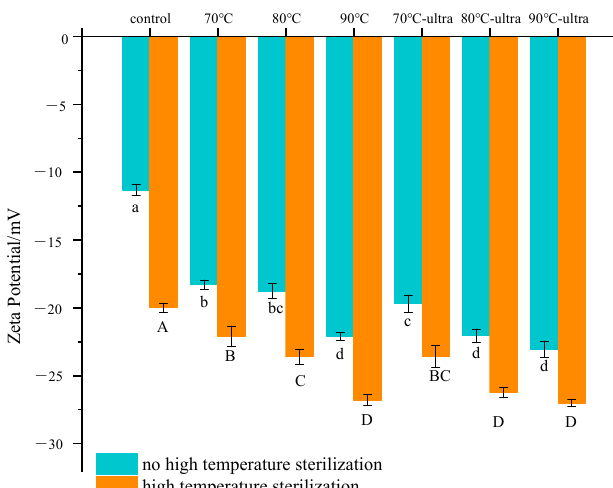
Figure 6. Zeta potential of different coconut milk samples (ultra: 53 kHz, 40 w / l ; 70, 80 and 90 ◦ C represent preheating for 20 min; high-temperature sterilization: 135 ◦ C for 60 s). Different letters indicate significant differences at p < 0.05.